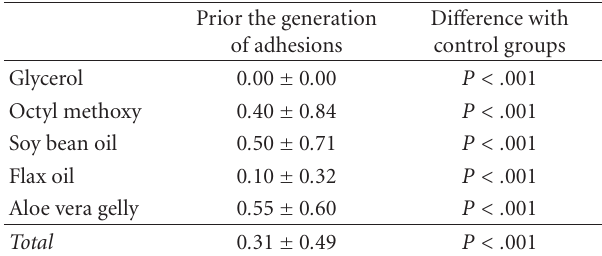
Table 3: Macroscopic adhesion scores of subgroups 3 (score of control group: 2 . 90 ± 0 . 21).